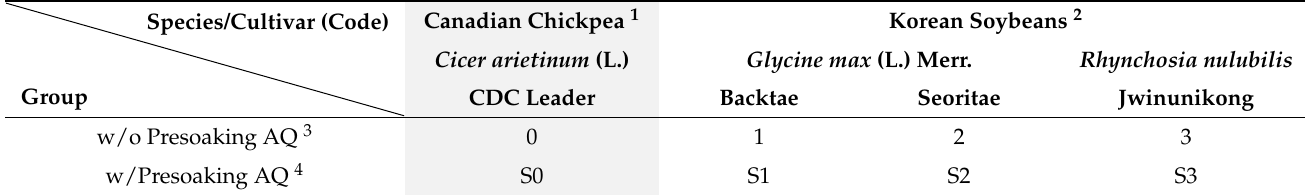
Table 1. AQ preparation